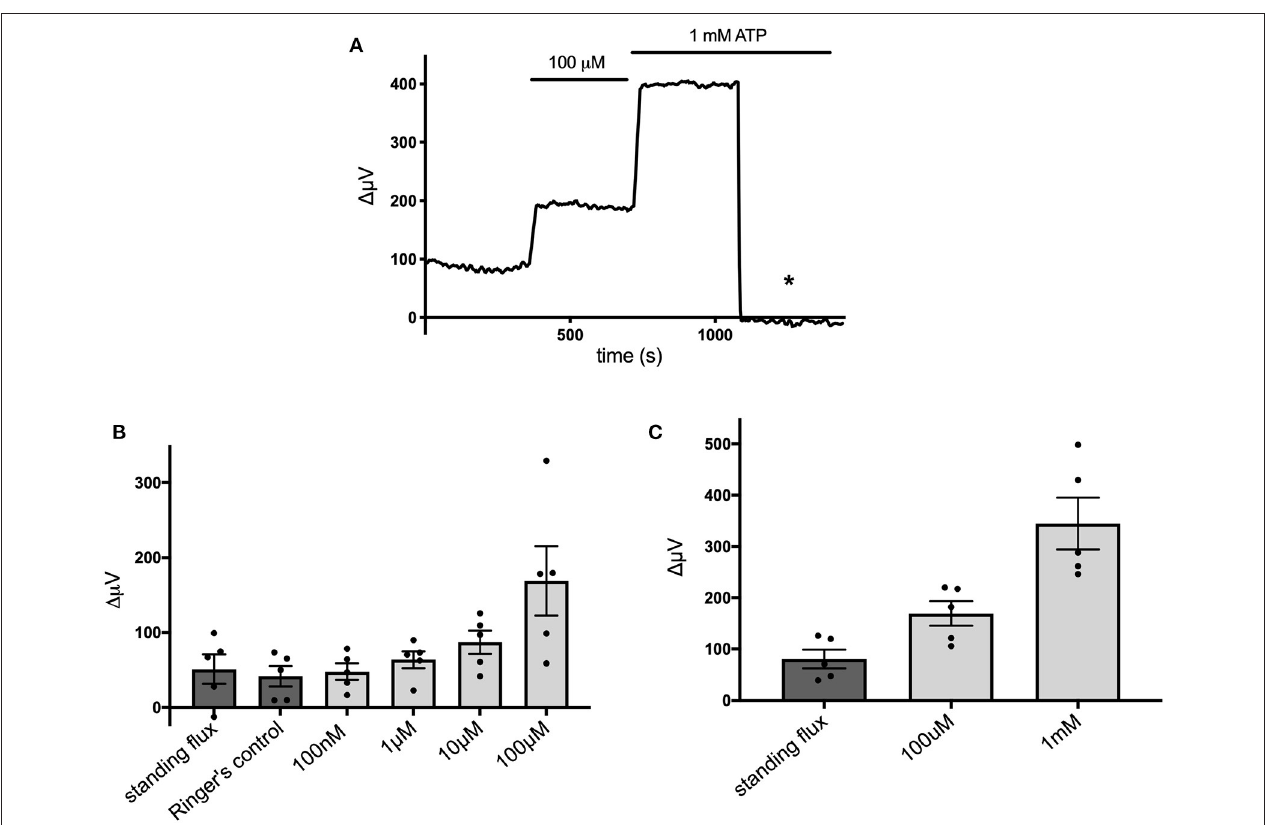
FIGURE 4 | Responses of cells cultured from hippocampus to different concentrations of extracellular ATP. (A) Response of one cell in saline solution containing 1mM HEPES to application of 100 µ M and 1mM ATP. (B) Average responses of cells to concentrations of extracellular ATP ranging from 100nM to 100 µ M; N = 5. (C) Average responses of additional cells to 100 µ M and 1mM extracellular ATP; N =